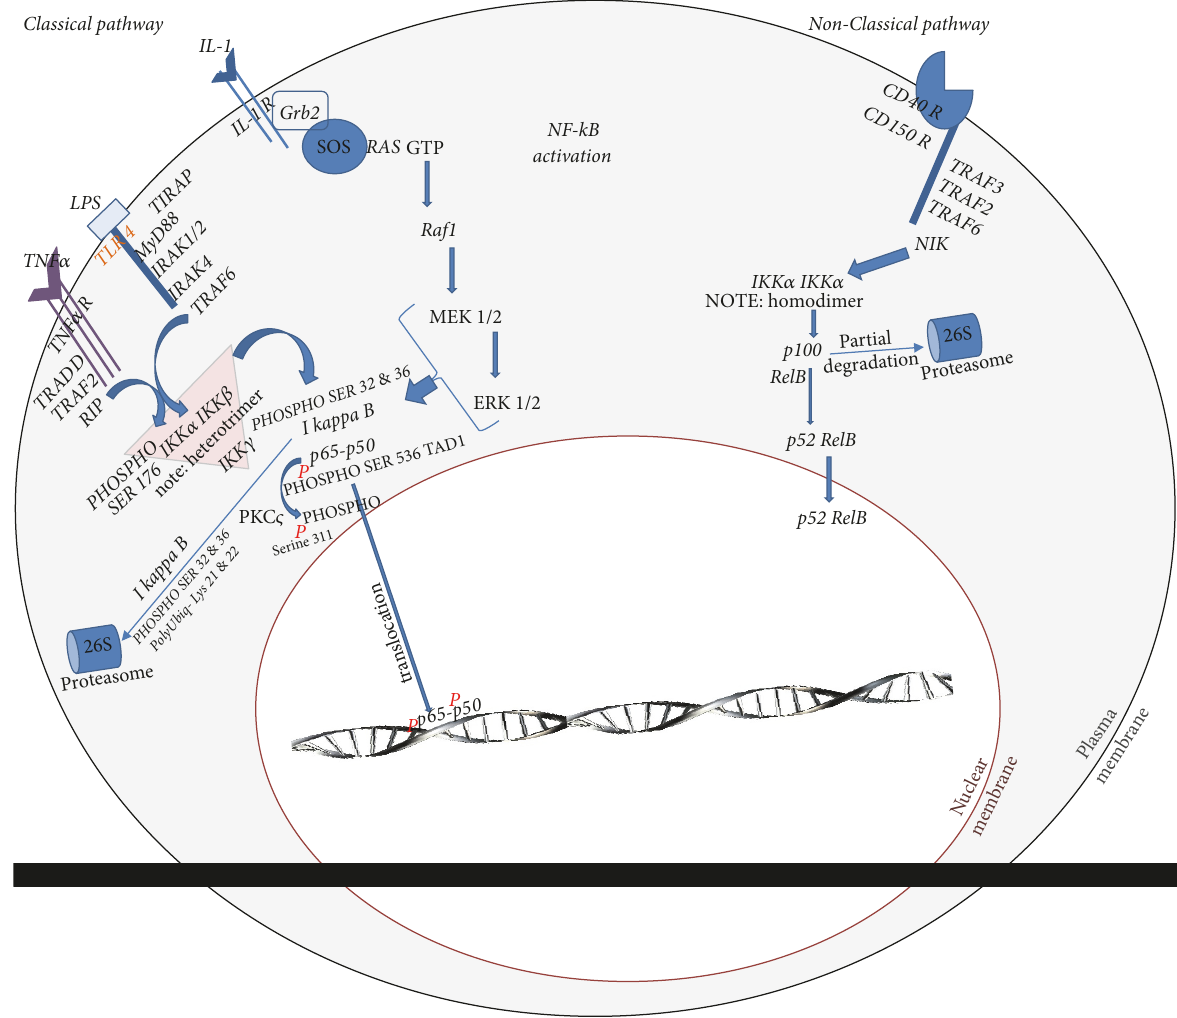
Figure 2: Depiction of classical and nonclassical pathway to NF-kB (p65-p50 or RelBp52) translocation activation. Figure: schematic by Franco